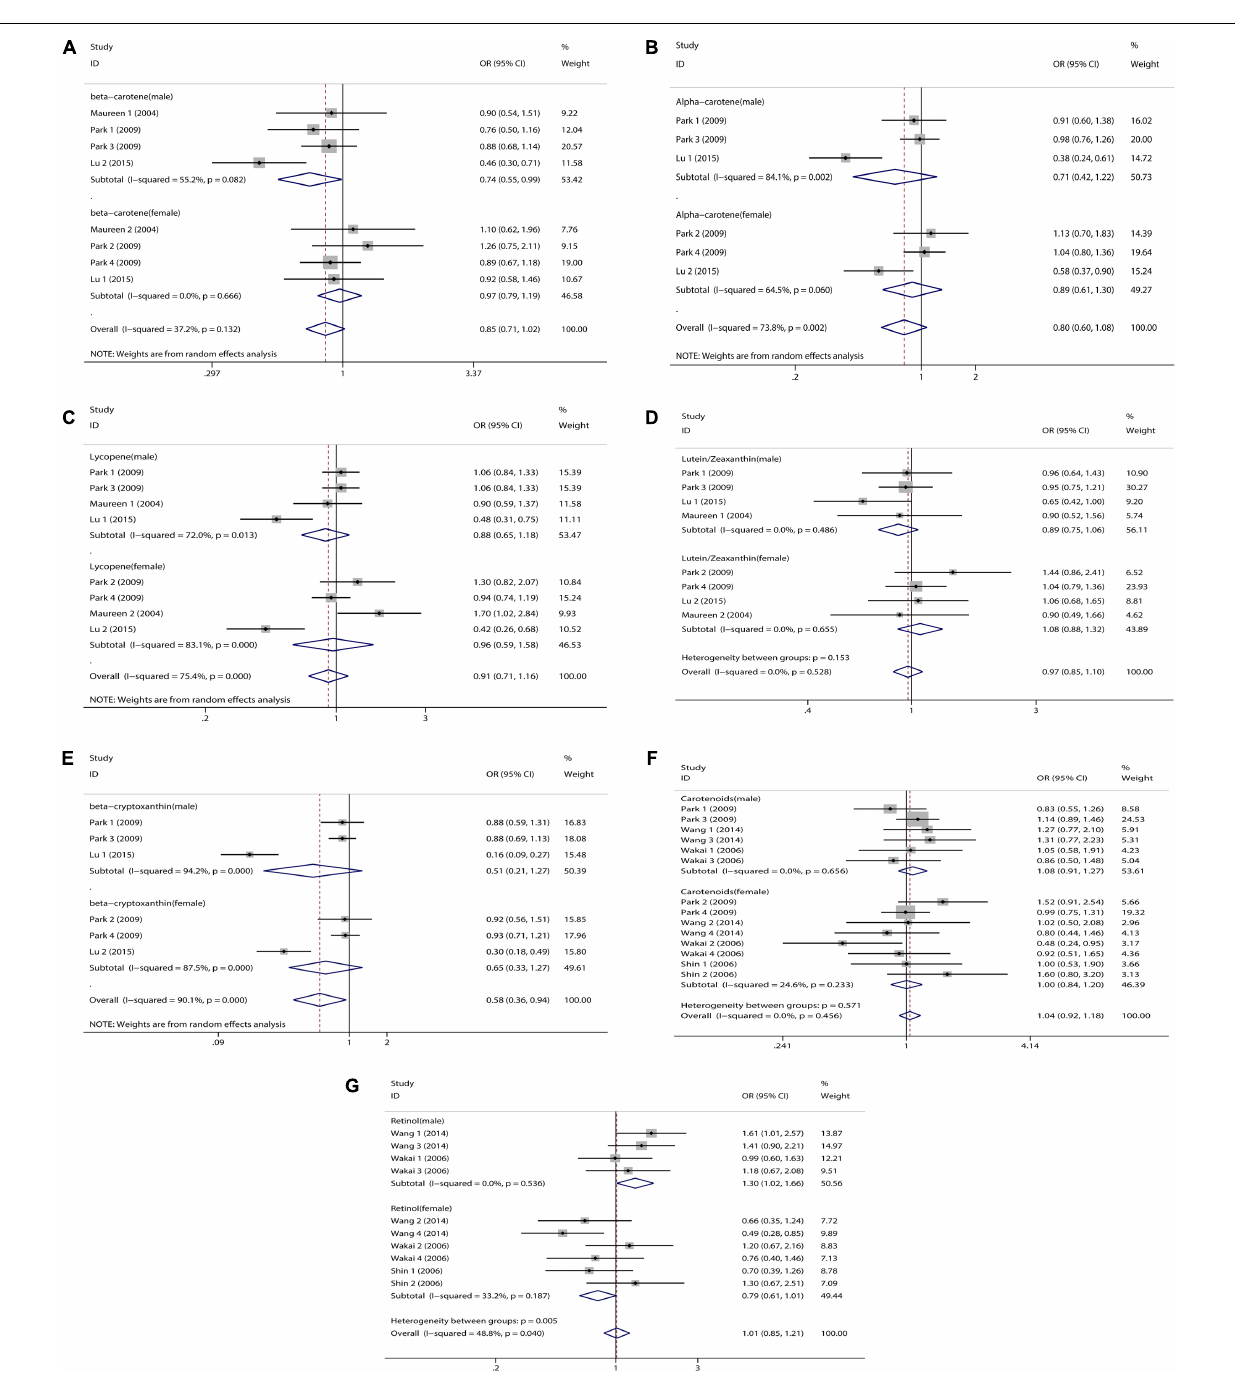
CI: 0.65–1.18, Figure 5C ), female (OR = 0.96, 95% CI: